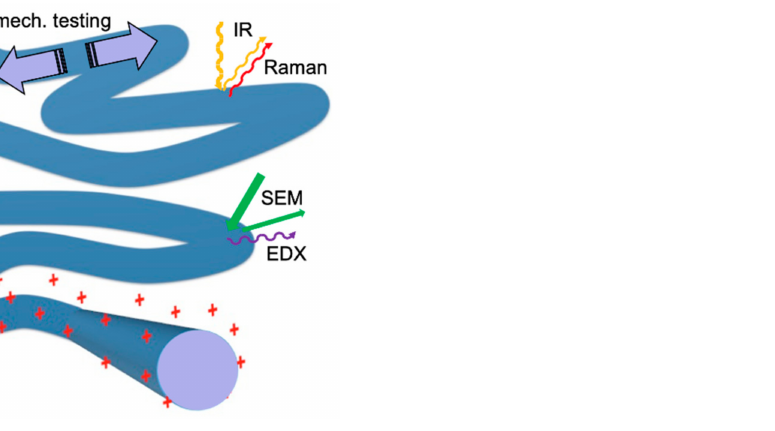
Figure 12. Micro- and nanoscale characterization methods. SEM, scanning electron microscopy; EDX, electron-dispersive X-ray spectroscopy; IR, infrared spectroscopy; Raman and fluorescence spectroscopy; XRD, X-ray diffraction; AFM, atomic force